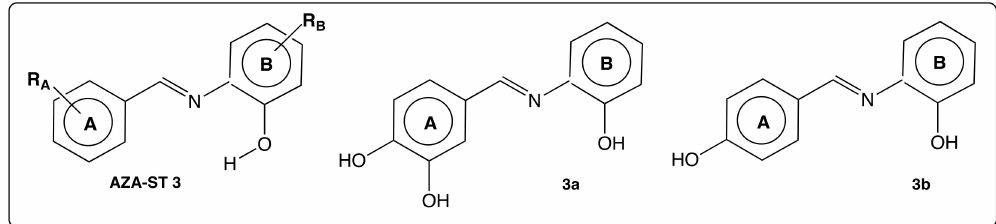
Figure 5. Structure of compounds of AZA-ST series 3 and AZA-ST 3a and 3b bearing OH in ortho position in ring B [51].